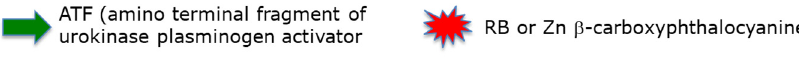
Figure 5. Preparation of multifunctional UCNPs. Adapted from Lu et al. [24]. In vitro tests were performed on H1299 cells (human lung cancer cells). After irradia- tion at 980 nm (0.5 W/cm 2 , 10 min), a viability of 10% was observed following incubation for 4 h with NPs (0.05 mg/mL).